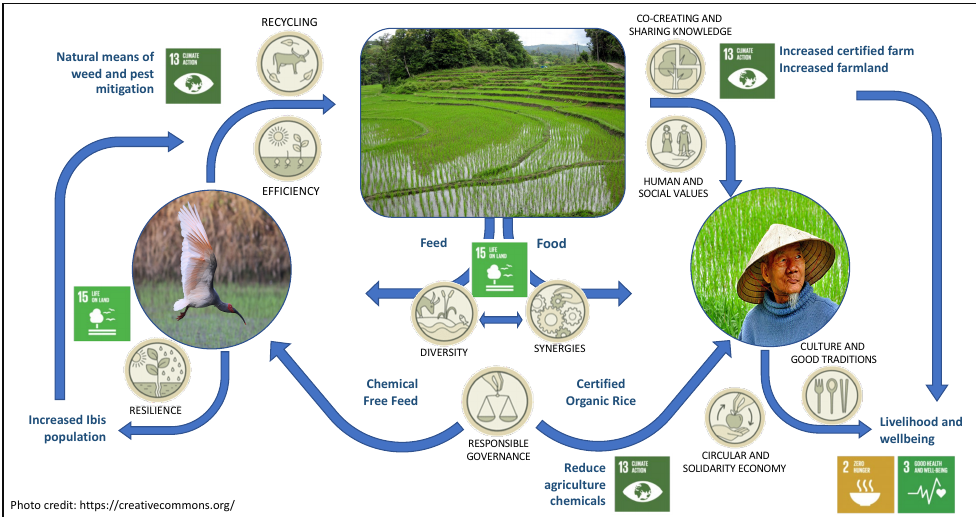
Figure2 Relationshipofthe"TokitoKurasuSato"ricecertificationsyatemwithagroecologyelementsandSustainableDevelomentGoals(SDGs) Figure 2. Relationship of the “Toki to Kurasu Sato” rice certification system with agroecology elements and Sustainable Development Goals (SDGs). This certification system is peculiar to Sado, aiming mainly at balancing agricultural promotion with environmental generation and promoting safe and sustainable rice